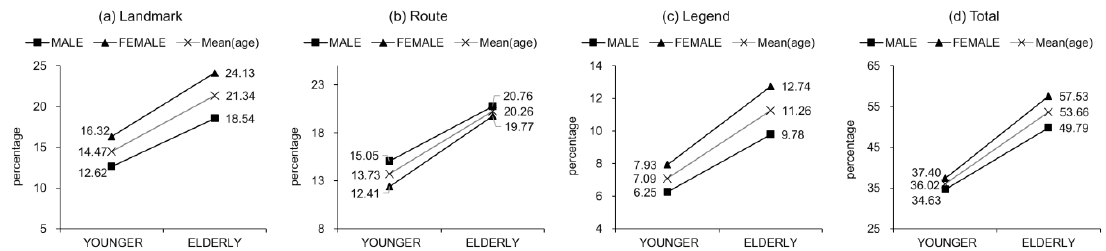
Figure 8. AOI divisions for route memorization. Table 5 and Figure 9 show the results of fixation durations on different types of AOIs. Males spent significantly less fixation duration on Landmark (M = 15.58 s, SD = 4.82) than females (M = 20.23 seconds, SD = 5.19, F(1, 19) = 8.17, p < 0.05), less fixation duration on Legend (M = 8.02 seconds, SD = 2.67) than females (M = 10.34 seconds, SD = 3.57, F(1, 19) = 6.31, p < 0.05), but more fixation duration on Route (M = 17.90 seconds, SD = 5.04) than females (M=16.09 seconds, SD = 4.76, F (1, 19) = 1.22, p > 0.05). In general, males spent less time on map memorization (M = 42.21 s, SD = 10.35) than females (M = 47.46 s, SD = 12.36), F (1,19) = 2.93, p > 0.05. Differences among age groups are consistent across the three types of AOIs. Elderly adults spent more time on memorizing Landmark (M = 21.34 s, SD = 5.33), Route (M = 20.26 seconds, SD = 3.65) and Legend (M = 11.26 seconds, SD = 2.59) than younger adults (Landmark: M = 14.47 seconds,